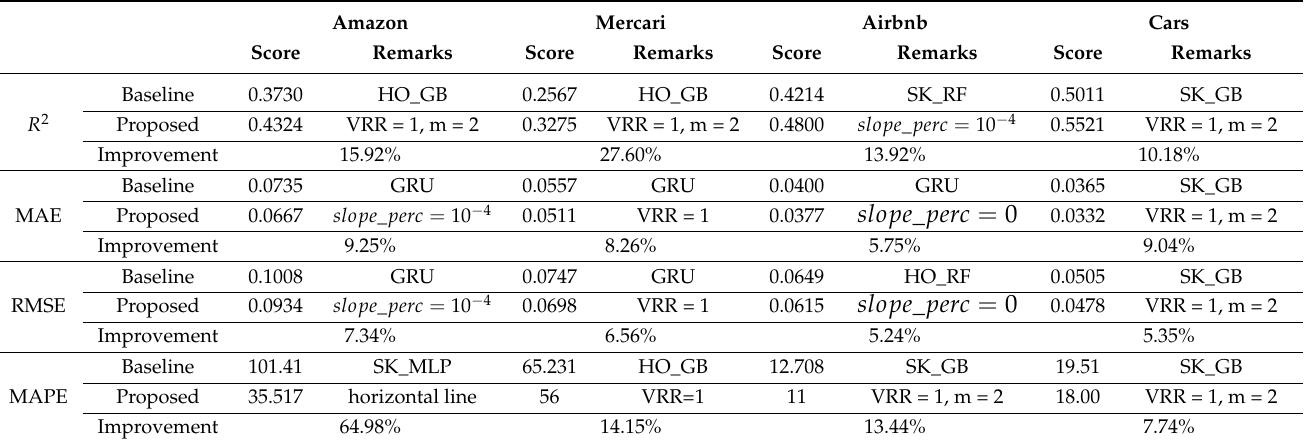
Table 4. Best improved model.